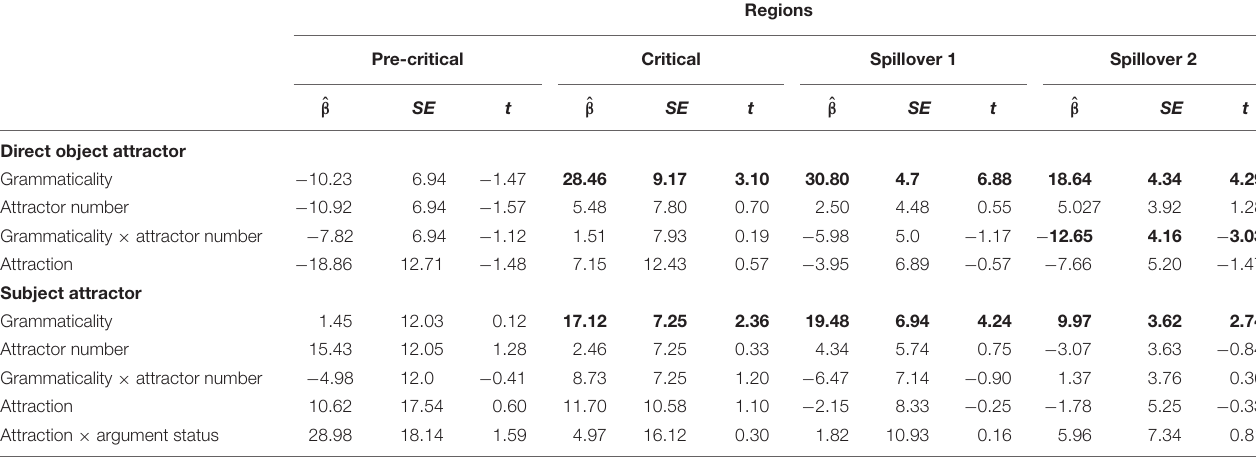
TABLE 6 | Summary of statistical analyses for direct object attractor conditions and subject attractor conditions in Experiment 2.